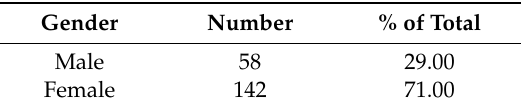
Table 2. Gender structure in the sample ( N = 200).